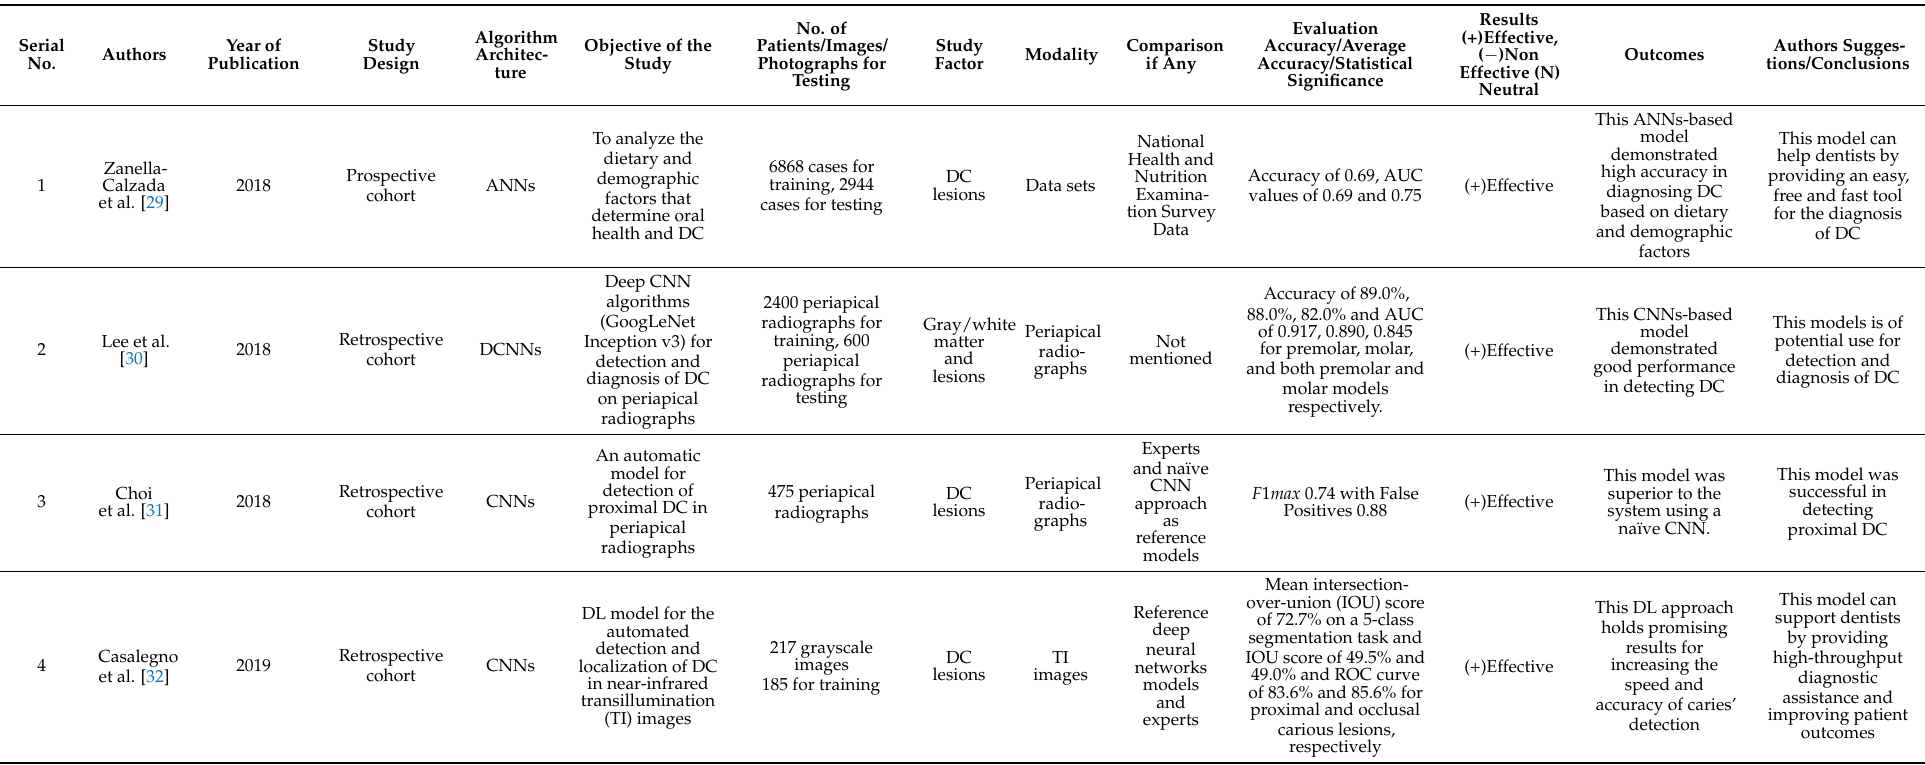
Table 2. Details of the studies that have used AI-based models for detection, diagnosis and prediction of